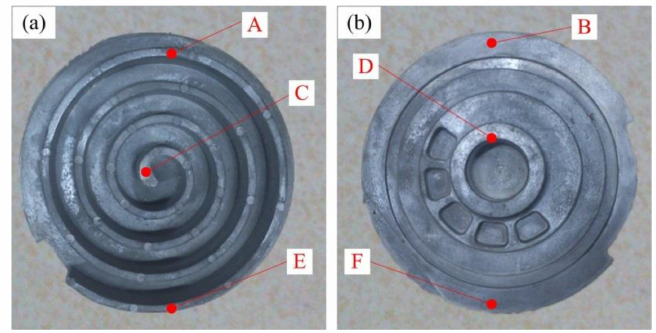
Figure 12. Macro morphology of the scroll: ( a ) front view and ( b ) back